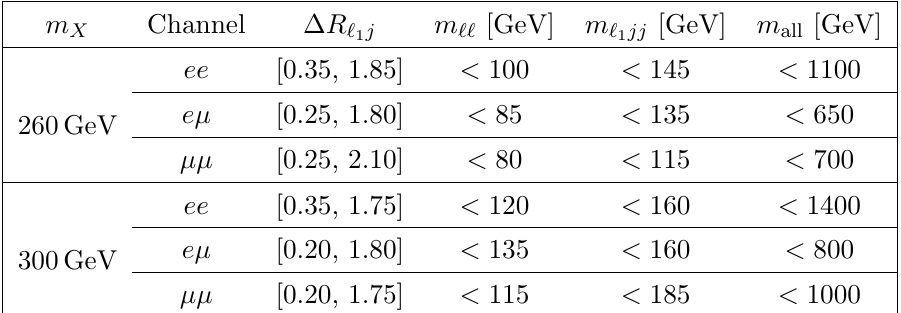
Table 4 . Optimised selection criteria used in the two lepton channel in the X ! HH search with m X = 260 GeV and m X = 300 GeV.